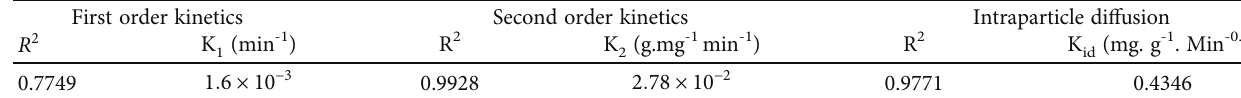
Table 2: Kinetics constants.